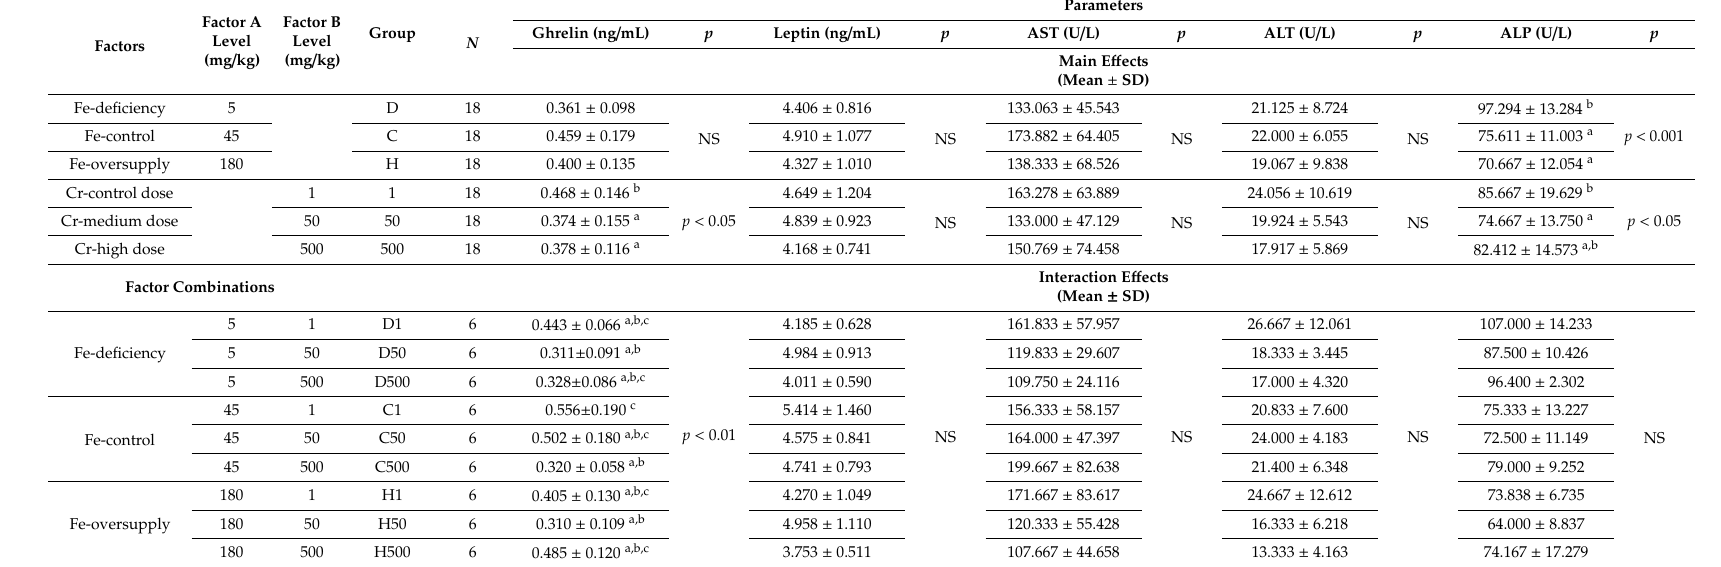
Table 4. The e ff ects of the Fe(III) and Cr(III) levels in the diet on the concentrations of selected hormones and enzymes in